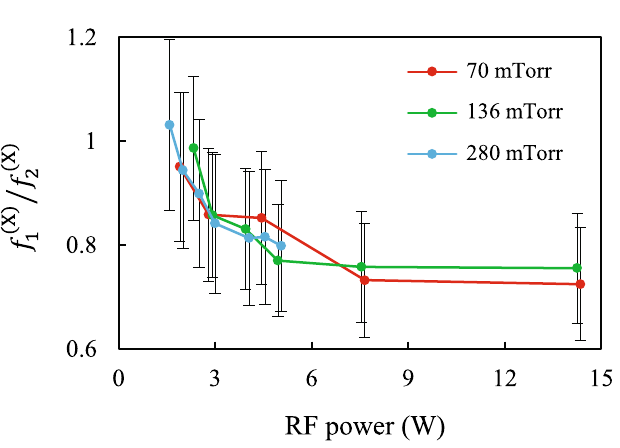
X ) ( X ) f ( Figure 5. Ratio f 2 of the derivatives of the external specific forces which confine the particles in the 1 horizontal direction, depending on the RF power at different gas (cid:31)